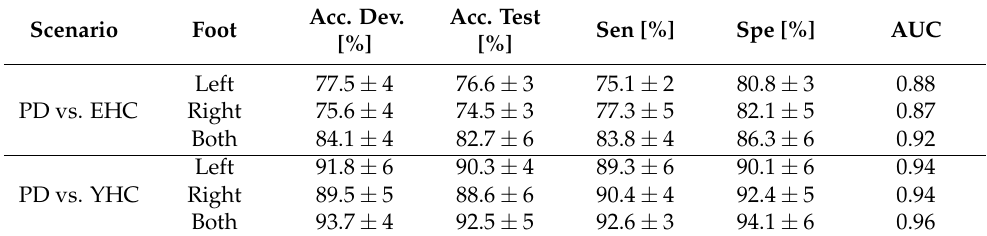
Table 5. Results using GRU and 4 × 10 m